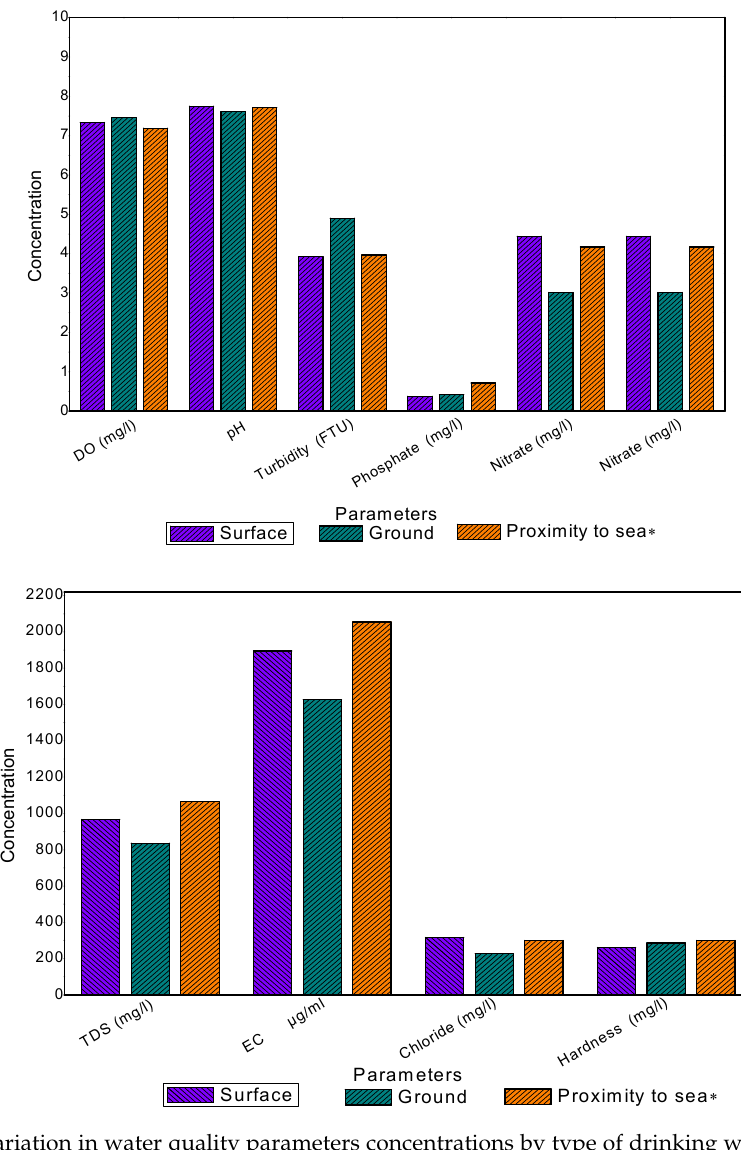
Figure 1. Variation in water quality parameters concentrations by type of drinking water source in schools. * The school located near the coast of the Arabian